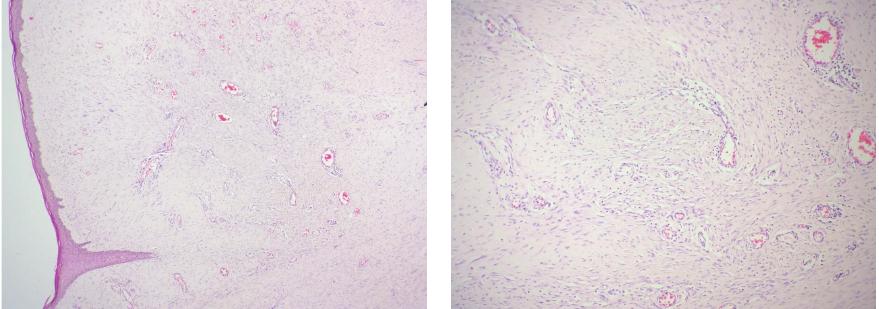
Figure 7: HPE of the mass showed proliferation of spindle/oval/stellate cells in fibrocollagenous stroma along with prominent vasculatures.